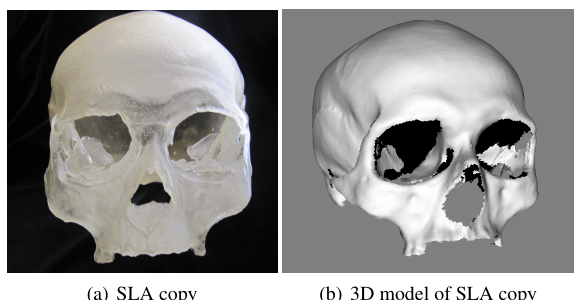
Figure 8. SLA copy of a skull and its 3D model